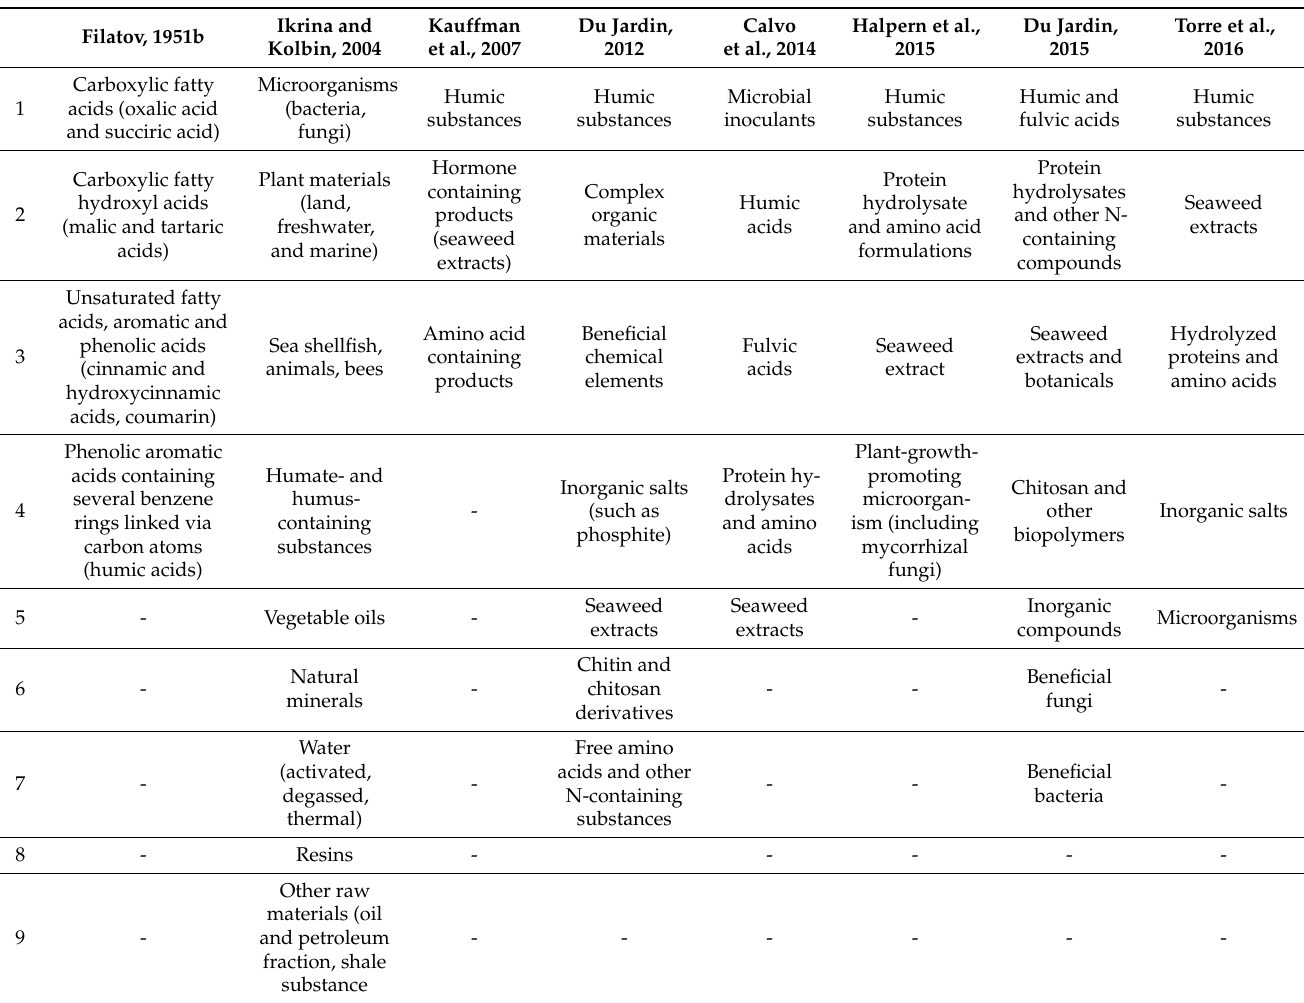
Table 1. Proposed biostimulant categories